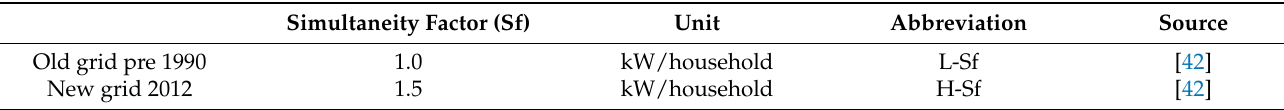
Figure 2. Example of NLDC and maximum grid loads based on Sf factors. Table 1. Simultaneity factors